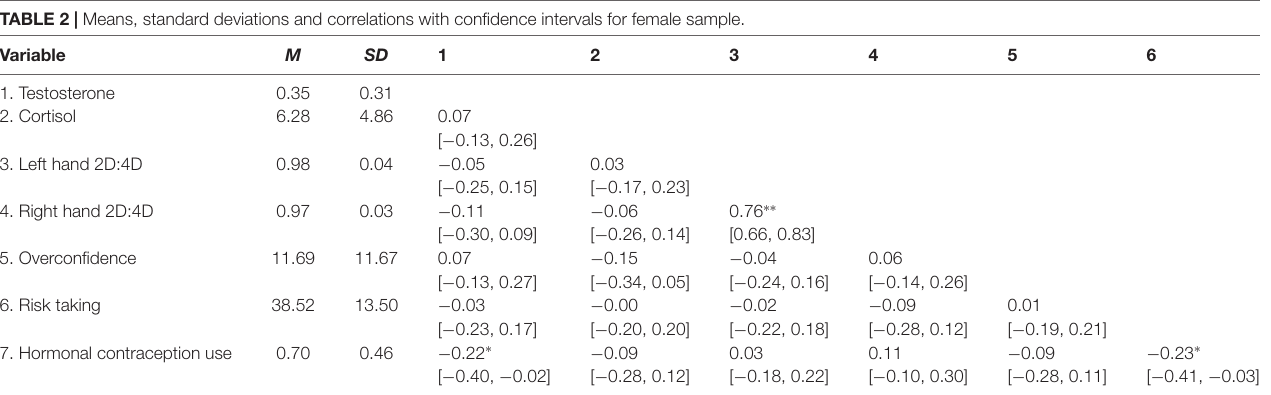
TABLE 2 | Means, standard deviations and correlations with confidence intervals for female sample. Variable